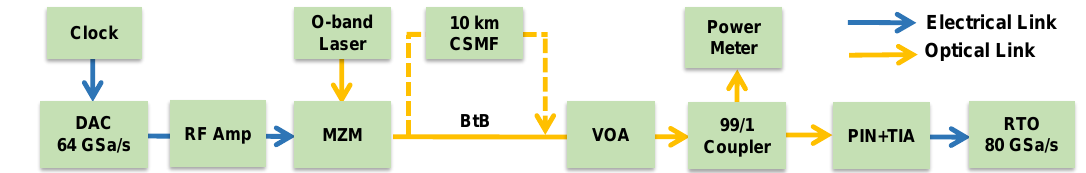
Figure 4. Experimental setup. Precoded PAM-M signals at different bit rates are launched and retrieved as PAM-M or DB-PAM-M sequences after being captured by the RTO. M = 2, 4. Adequate sampling and slicing using, respectively, M − 1 and 2 M − 2 thresholds, are required.